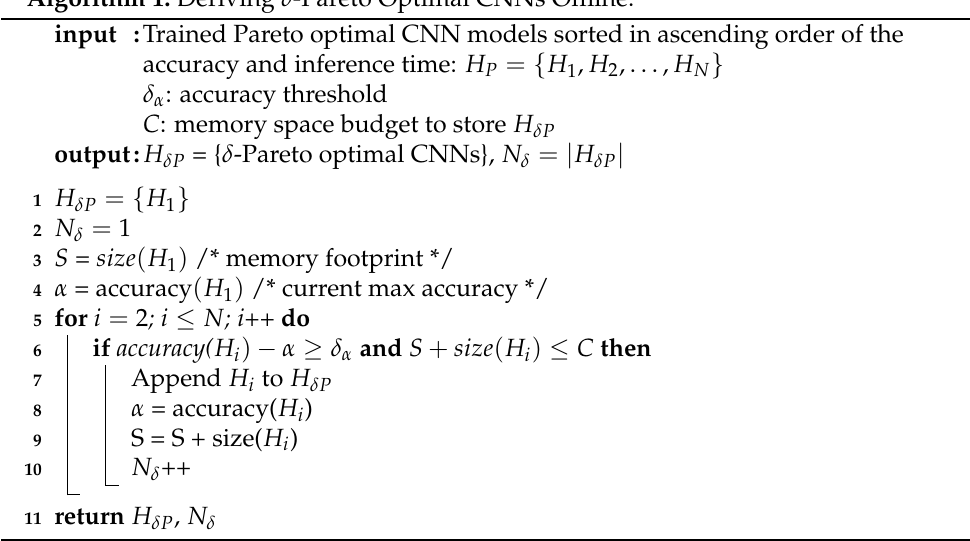
Algorithm 1: Deriving δ -Pareto Optimal CNNs Offline.